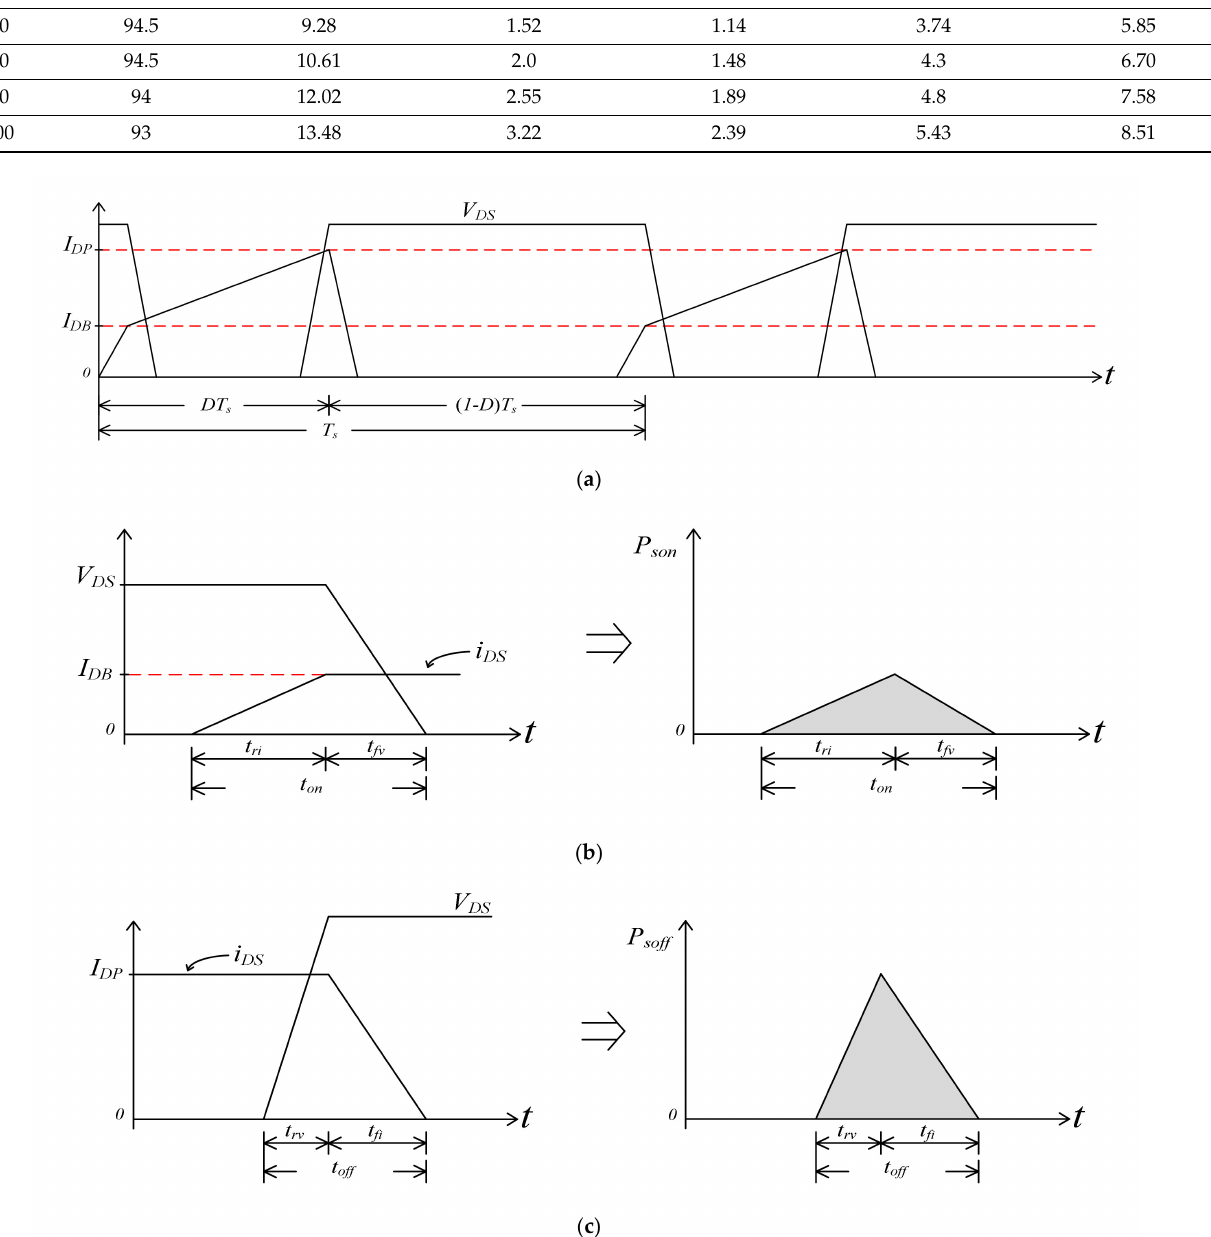
Figure 13. Conceptual waveforms of switching loss during ( a ) a complete switching cycle ( b ) switch turn-on transition, and ( c ) turn-off